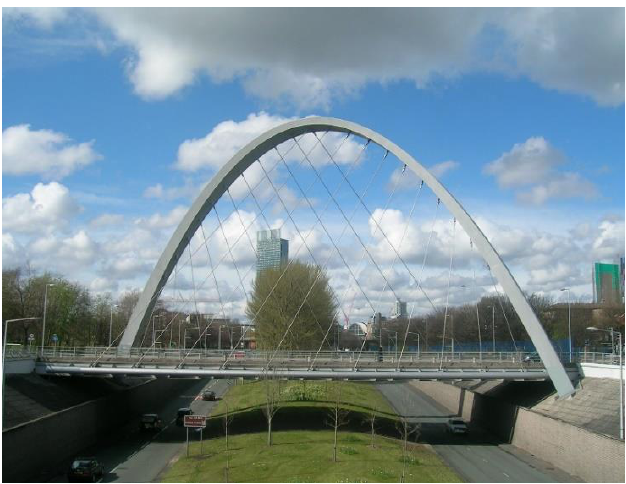
Figure 1. Hulme Arch (Photo: https://www.flickr.com/photos/raver_mikey Creative Commons).